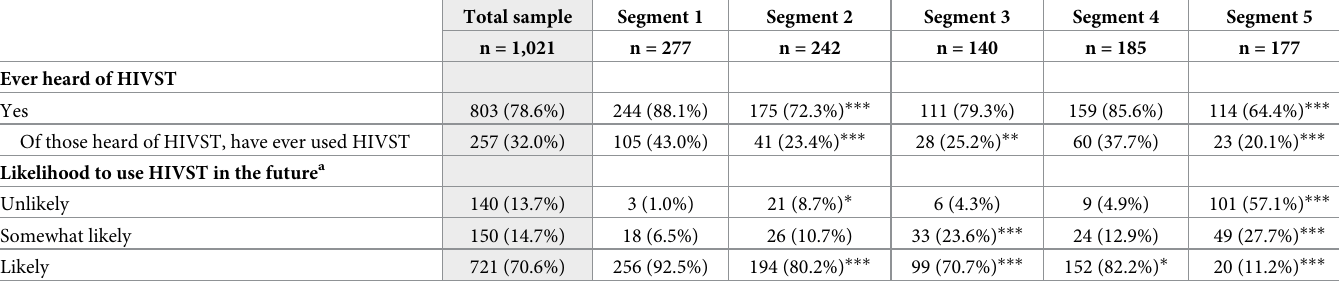
Table 3. HIVST awareness and use, by segment.